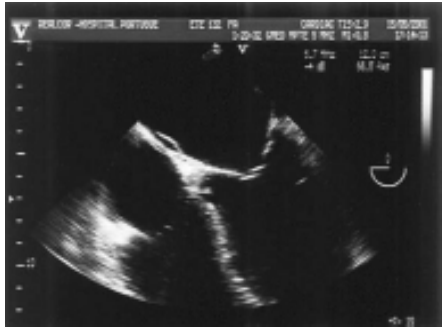
Fig. 1 – Aspect of the transoesophageal echocardiogram performed three months after trauma